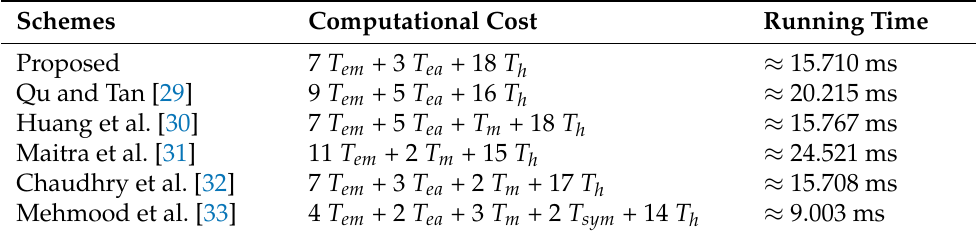
Table 5. Computational cost for executed operations in the proposed scheme and other similar schemes.